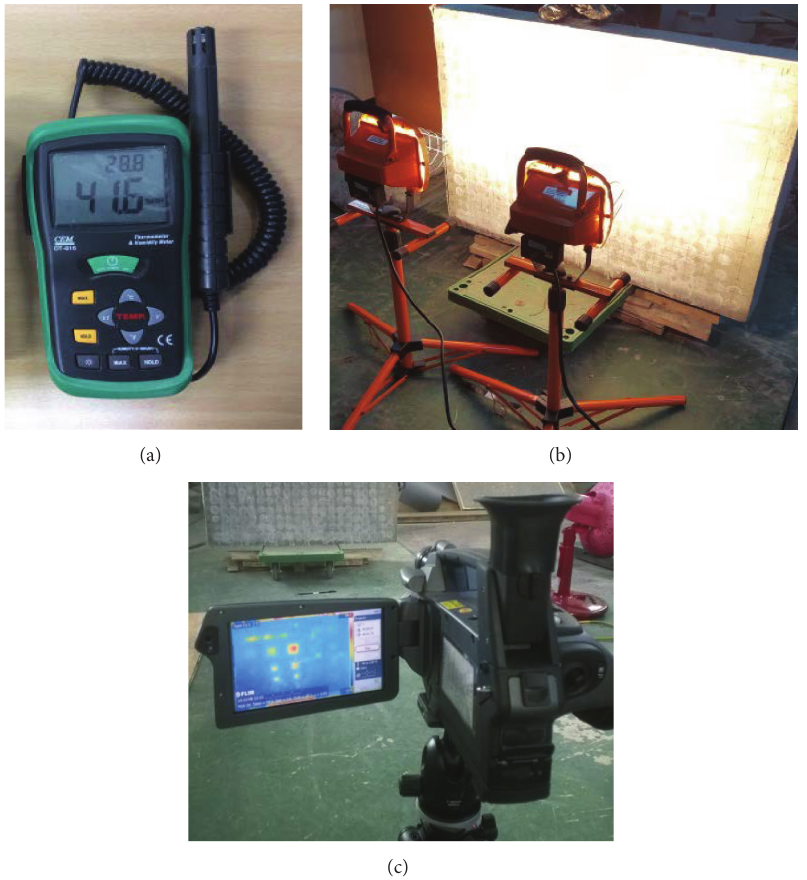
Figure 4: Equipment utilized in the experiment: (a) CEM DT-615, (b) Halogen lamps, and (c) IR thermal camera.